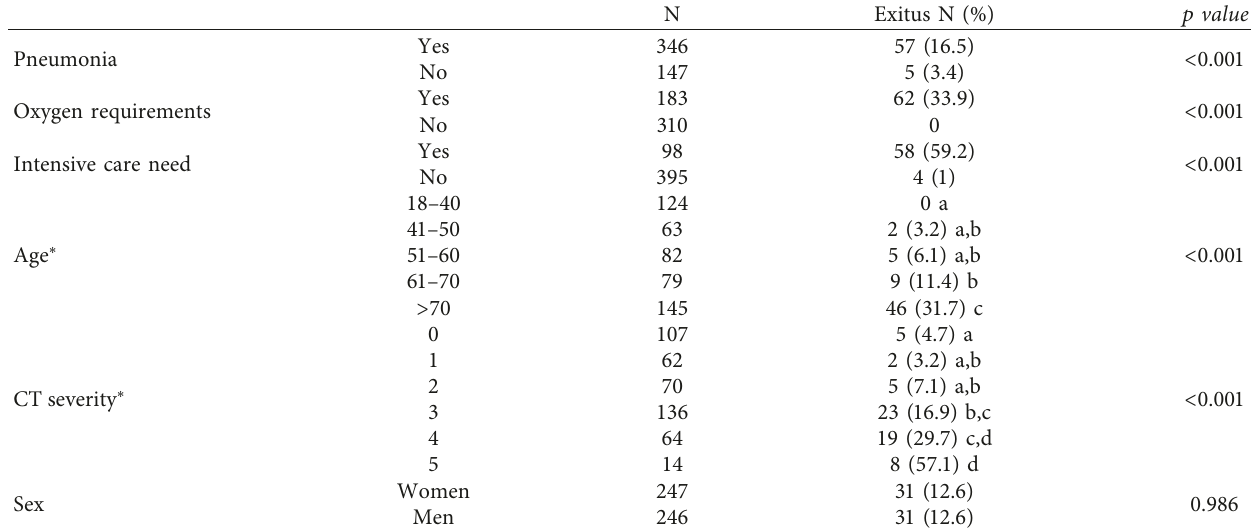
Table 1: Distribution of exitus